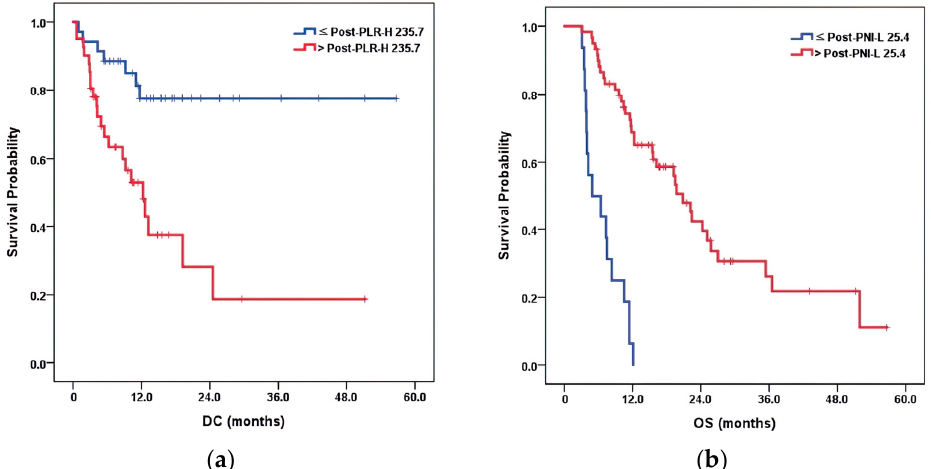
Figure 2. Kaplan ‒ Meier curves for DC ( a ) and OS ( b ). Figure 2. Kaplan–Meier curves for DC ( a ) and OS ( b